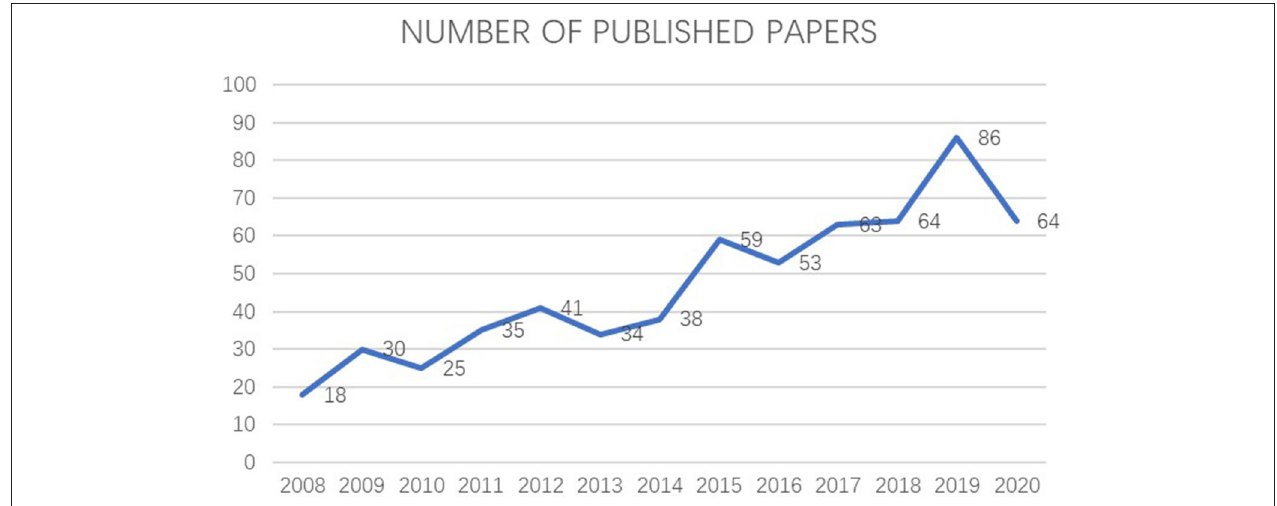
FIGURE 1 | Trend chart of the number of articles published on BPD in extremely pre-mature